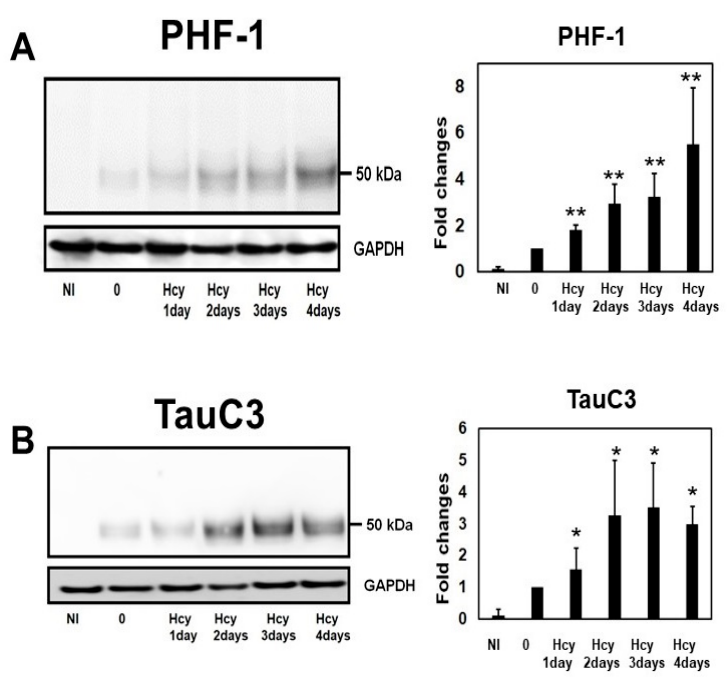
Figure 6. Temporal profile of phosphorylated tau and caspase-cleaved tau following homocysteine (Hcy) treatment. Time courses of phosphorylated tau and caspase-cleaved tau were examined with Hcy (100 µM) treatment for 1 day, 2 days, 3 days, and 4 days. Phosphorylated tau was increased most when the cells were treated for 4 days ( A ). However, the caspase-cleaved tau levels were increased after 2 days of Hcy treatment and remained high through the 4th day ( B ). N = 4, NI: non-induced cells, Bar ± SD, * p < 0.05, ** p < 0.01.